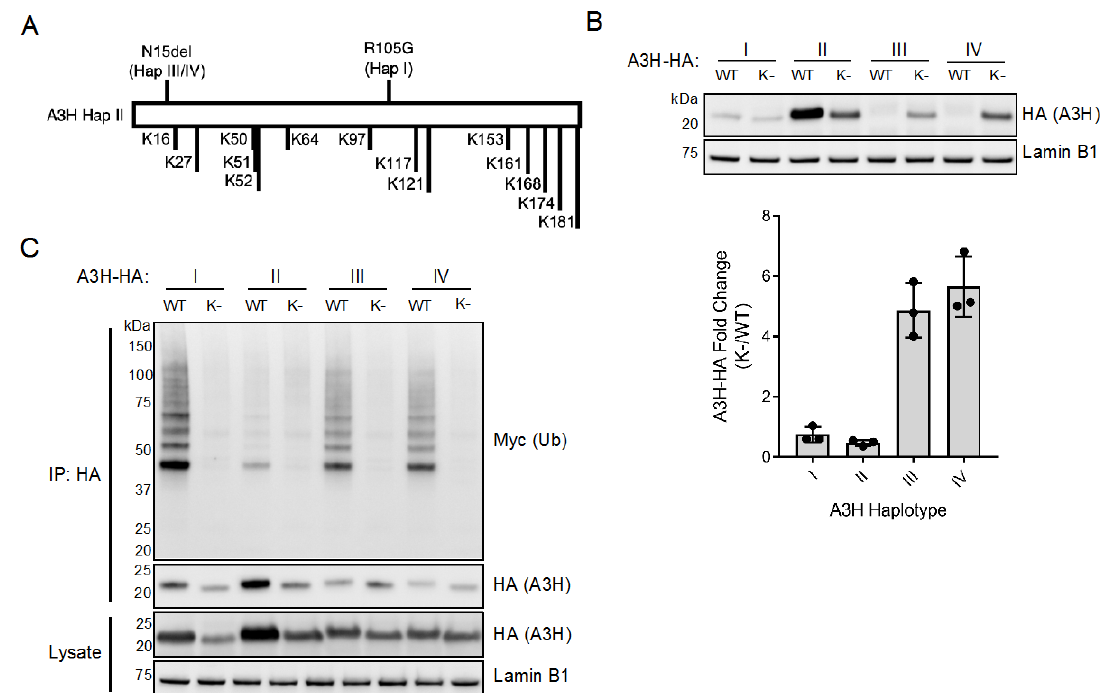
Figure 2. Genetic inhibition of ubiquitination increases expression of A3H haplotypes III and IV. ( A ) Protein schematic of A3H haplotype II (A3H Hap II) highlighting the polymorphic sites of haplotypes I (Hap I, R105G) and haplotypes III and IV (Hap III/IV, N15del), as well as all lysine residues (K) present in A3H. ( B ) Top: Immunoblot of wild-type (WT) and lysine-less (K-) A3H haplotypes expressed in 293T cells. Western blotting of whole cell lysates was performed using anti-HA to assess for A3H levels, and anti-Lamin B1 as a loading control. Bottom: Densitometric analysis of three independent experiments. Expression of A3H-HA was normalized to Lamin B1 levels and plotted as the fold change of lysine-less (K-) over wild-type (WT) haplotypes. Error bars indicate standard deviation from the mean. ( C ) Immunoblot of ubiquitinated wild-type (WT) and lysine-less (K-) A3H haplotypes co-transfected in 293T cells alongside myc-tagged ubiquitin (myc-Ub). Whole cell lysates were immunoprecipitated with anti-HA resin, and Western blotting was performed with anti-HA and anti-myc antibodies. Western blotting of whole cell lysates was performed using anti-HA to confirm expression of A3H, and anti-Lamin B1 as a loading